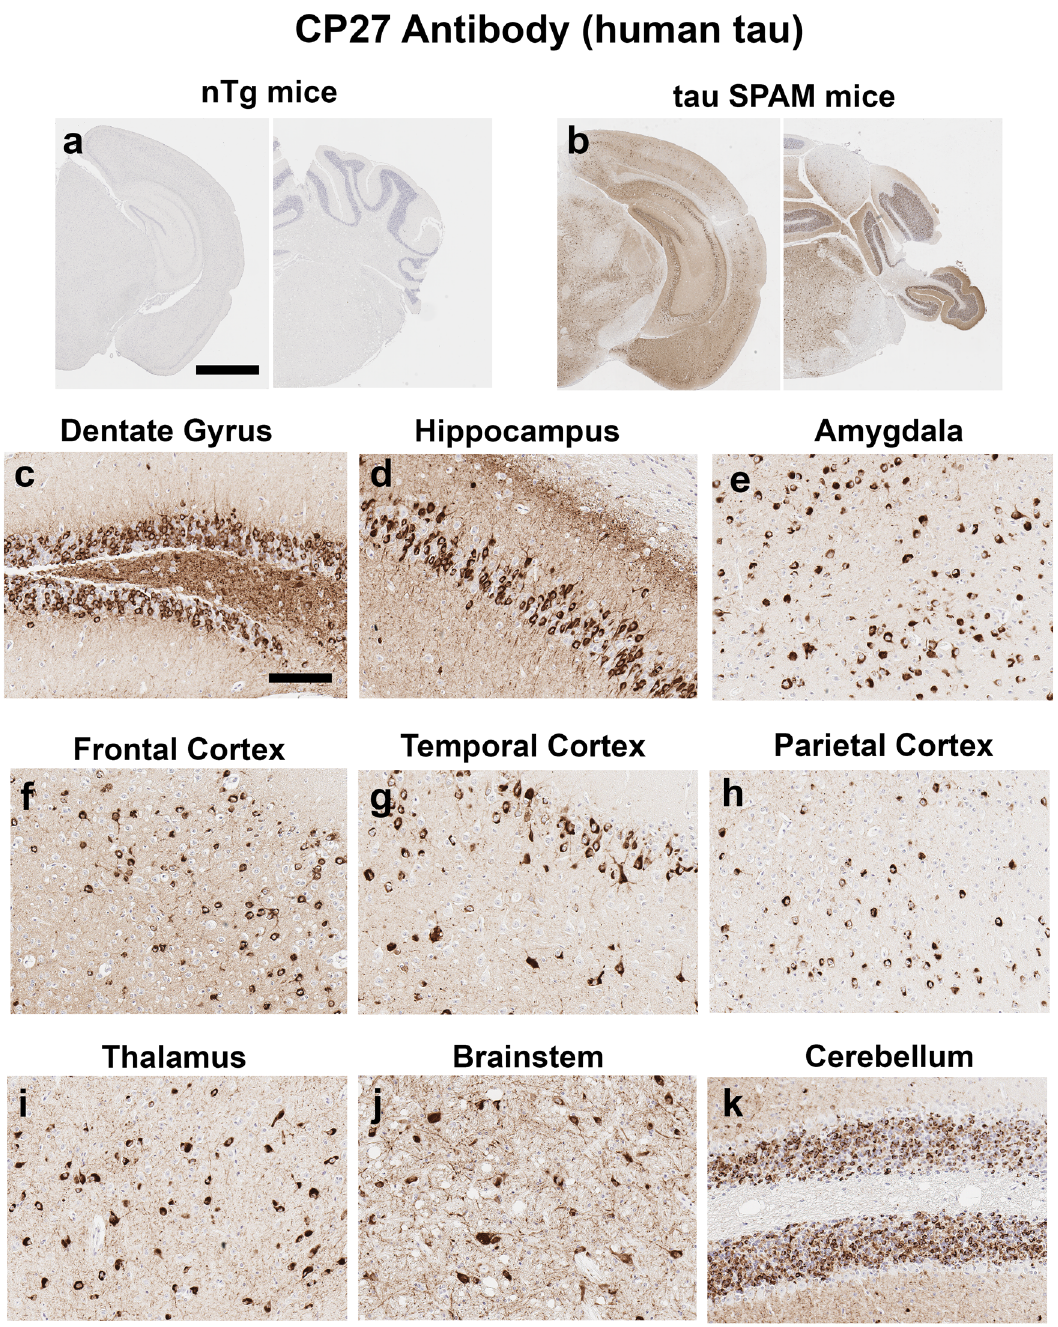
Fig. 2 Tau SPAM mice develop robust NFT-like tau inclusions throughout most of the brain neuroaxis, particularly in the hippocampus and cortex. a , b IHC with antibody CP27 speci fi c for human tau does not stain brain tissue from nTg mice, but reveals a high density of tau inclusions in 6-month-old tau SPAM mice. Scale bar = 1.333 mm. Higher-magni fi cation pictures show abundant perikaryal NFT-like tau inclusions in all major areas of the brain, including ( c ) dentate gyrus, ( d ) hippocampus, ( e ) amygdala, ( f ) frontal cortex, ( g ) temporal cortex, ( h ) parietal cortex, ( i ), thalamus, ( j ) brainstem, and ( k ) granular layer of the cerebellum. Tissue sections were counterstained with hematoxylin. Scale bar = 100 μ